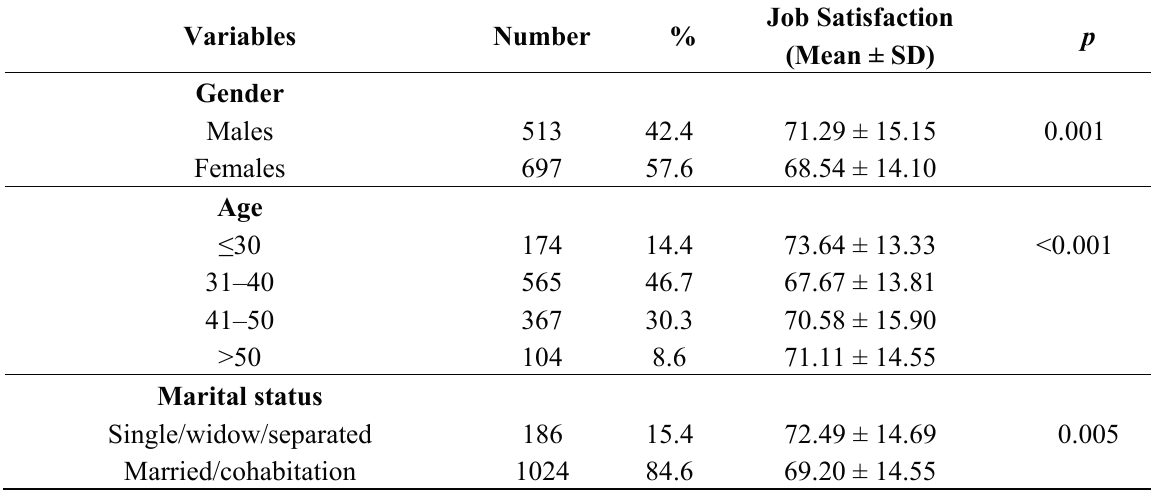
Table 1. Participants’ characteristics and differences in job